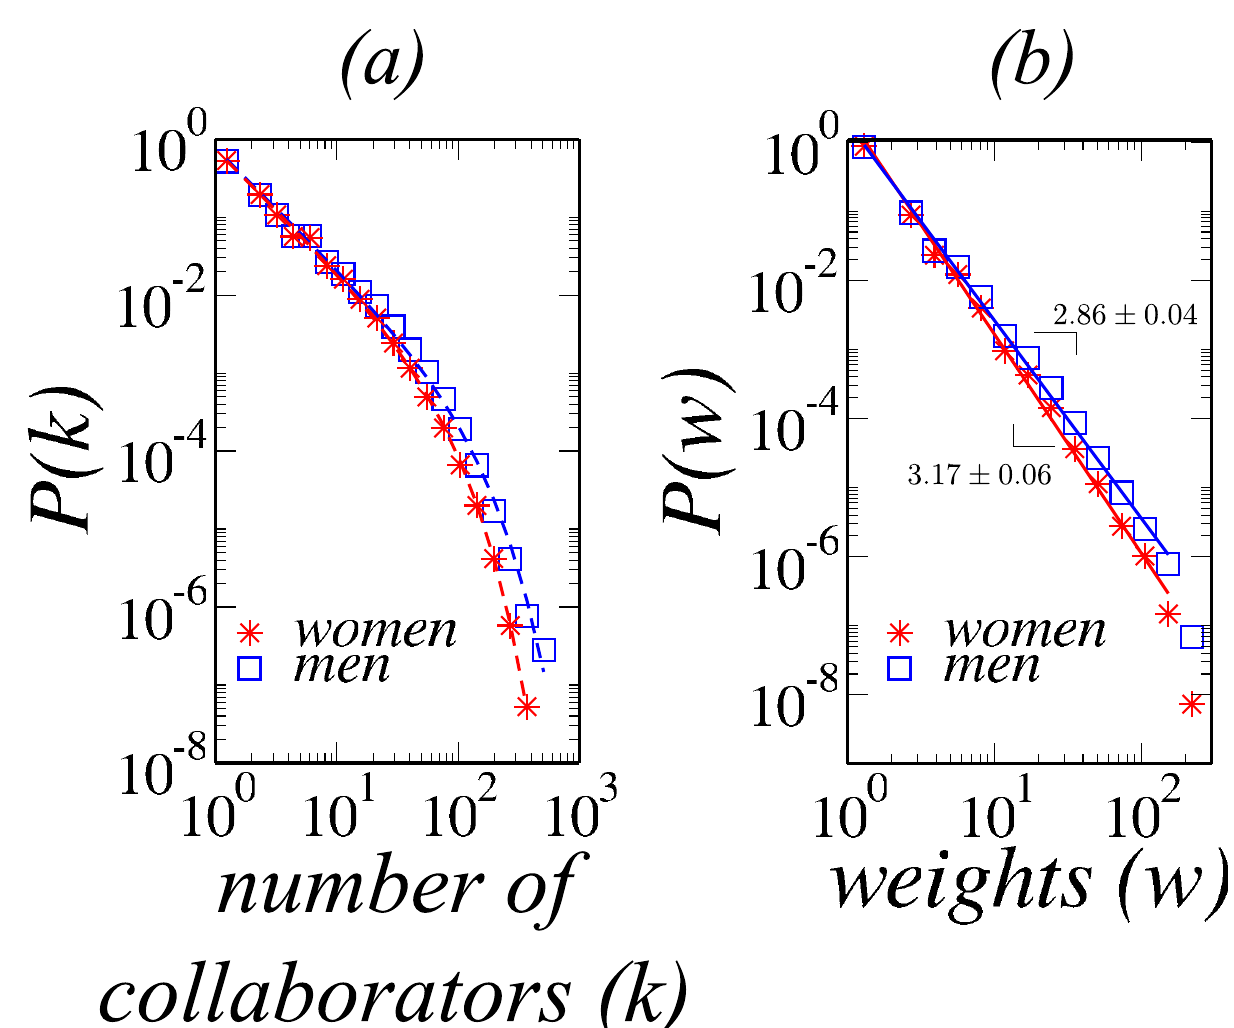
Fig 1. a) Distributionof the number of collaborators for men (blue squares)and women (red asterisks). The distributions are fitted with a truncated power law, P ( k ) = Ak −α e − k/ β , plotted as dashed lines with colors correspondingto data points. The best fit is obtainedfor α = 1.53, and β = 85.4 and β = 49.5, for men and women, respectively,with r-squared0.996 for men and 0.999 for women. b) Distributionof the number of recurrent collaborations betweenscientists (weights)for men (blue squares) and women (red asterisks). Solid lines are power- law fits, P ( w ) = Bw −λ , with colors corresponding to data points. For men, λ = 2.86 ± 0.04, whilefor women λ = 3.17 ± 0.06. With r-squared 0.997 for men and 0.996 for